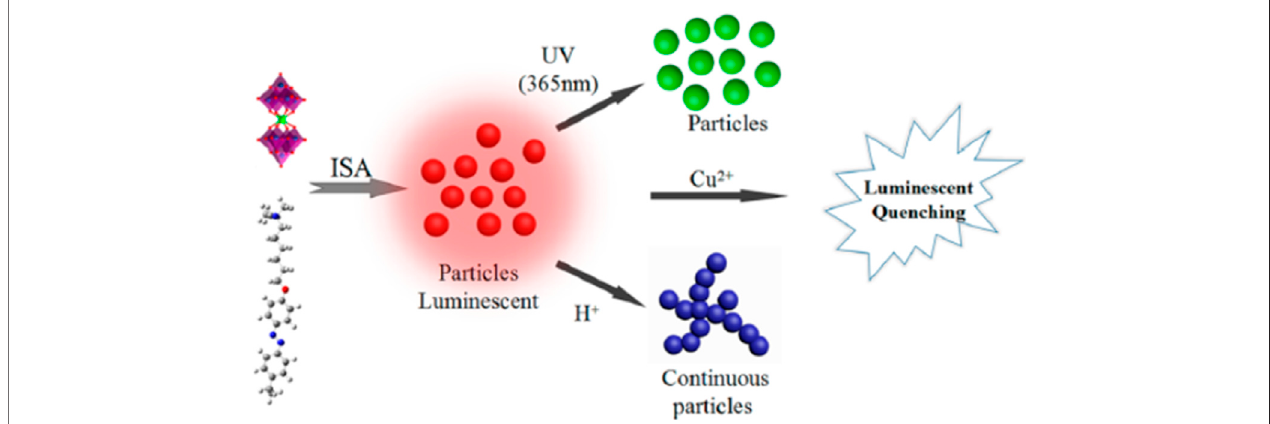
FIGURE 25 | Formation of ETAB/Eu-POM supramolecular materials and their responsiveness to UV Light, Cu 2+ , and H + . (Guo et al., 2016b). Reprinted with permission. Copyright © 2016 American Chemical Society.